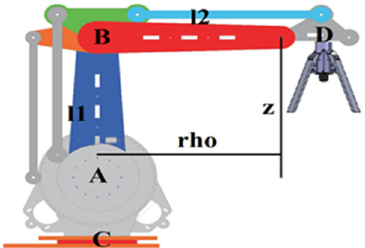
Figure 5. Axes of the robotic arm.